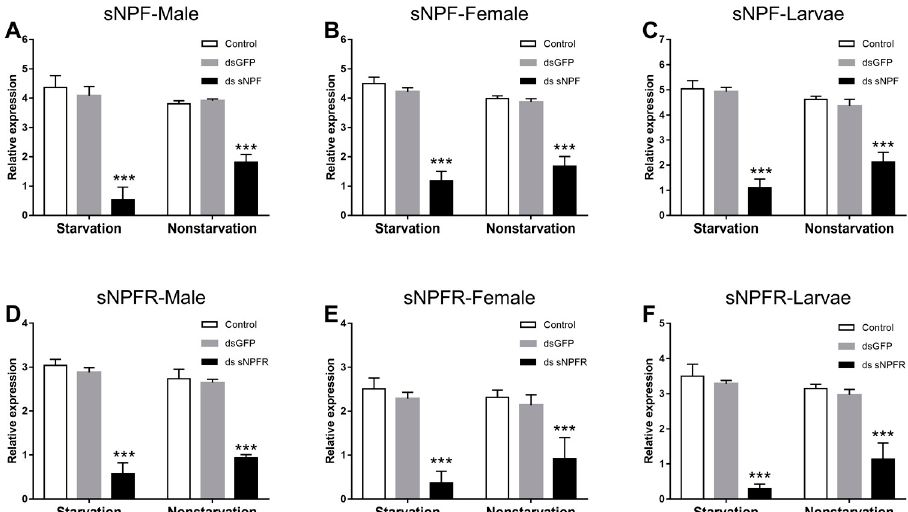
Figure 6. Knockdown of sNPF-Male ( A ), sNPF-Female ( B ), sNPF-Larvae ( C ), sNPFR-Male ( D ), sNPFR-Female ( E ), and sNPFR-Larvae ( F ) expression levels in D. armandi after dsRNA injection for 72 h in the states of starvation and non-starvation. The relative expression levels were normalized with β -actin and CYP4G55 . The asterisk indicates a significant difference betweent dsRNA reatment group and the two control groups (*** p <0.001, one-way ANOVA). All values are mean ± SE, n = 3.